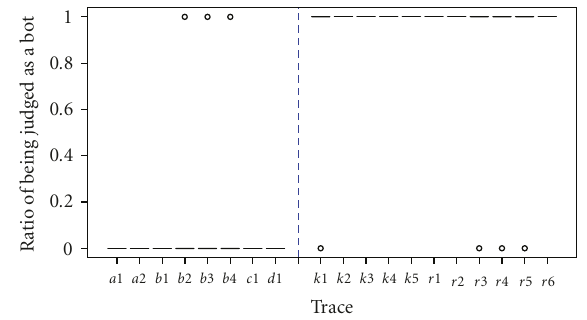
Figure 15: Bot identification results using the burstiness trend method.